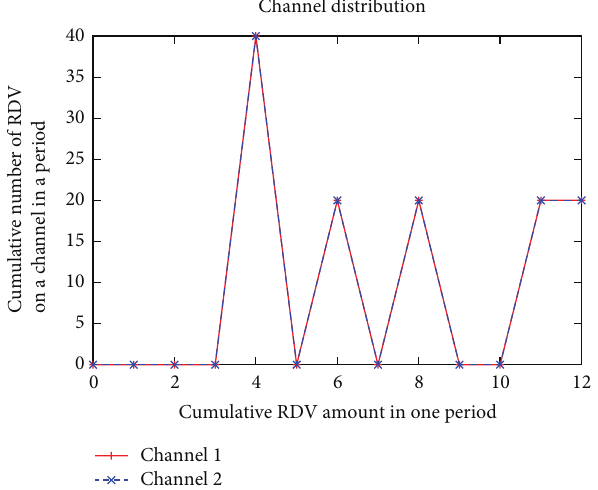
Figure 16: MtQS-DSrdv in ACHv: the combination of maps with 2 and 8 channels (120 slots).